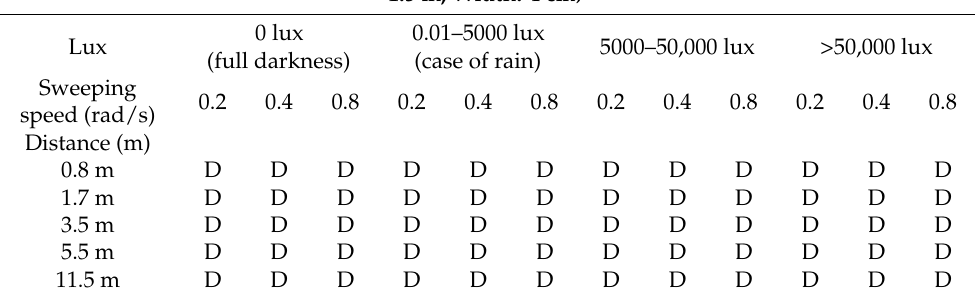
Table 1. This table shows the results of detection for a large dark obstacle at different distances, sweeping speeds and illuminations (D means detected, and ND means not detected). The results were the same for large and thin white obstacles, so we summarize the three cases in the same table. Large Dark or White Obstacle (Length: 1.2 m; Width: 50 cm), Thin White Obstacle (Length: